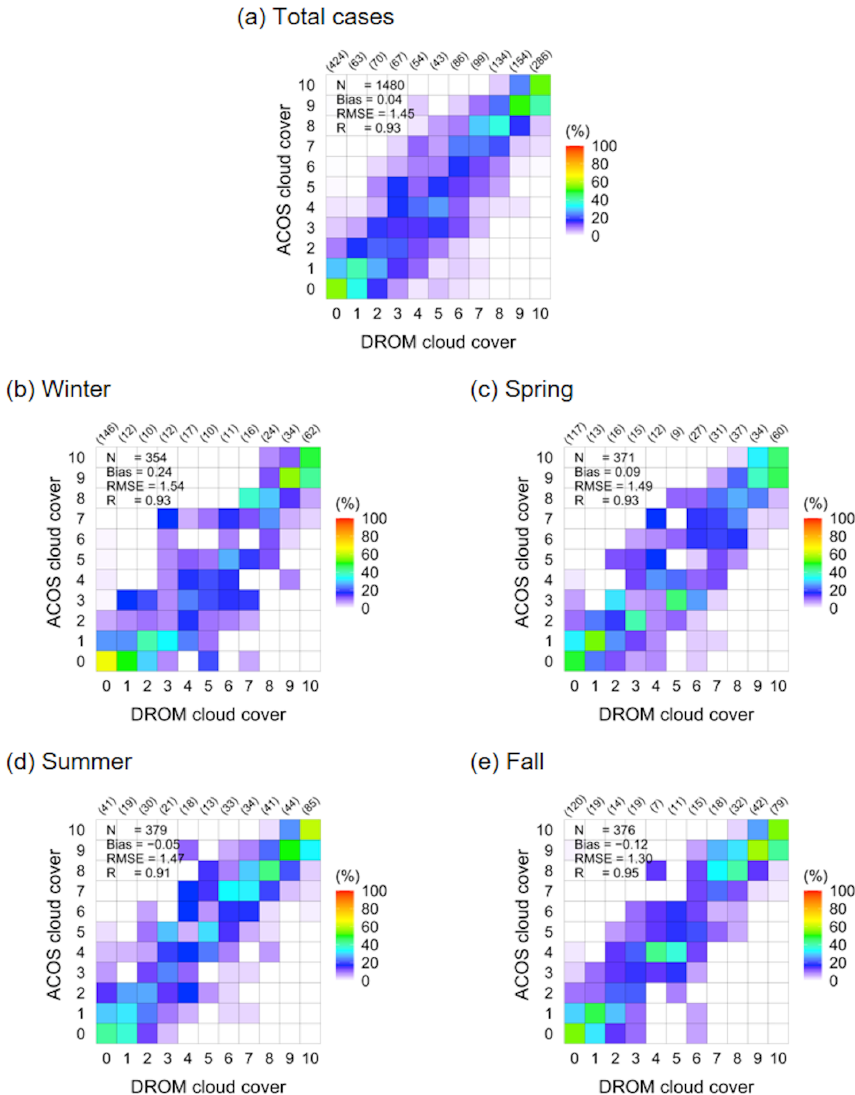
Figure 6. Scatter plots of total (a) and seasonal (b–e) cloud cover based on observed (DROM) and calculated (ACOS) cloud cover for the test set. Parentheses values are the number of observations for each cloud cover in DROM.